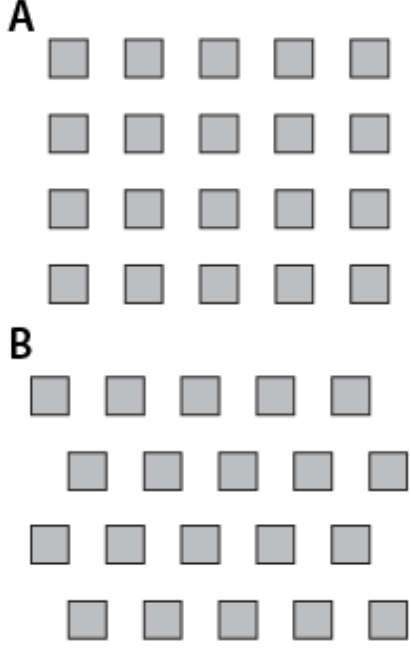
Figure 2. The two grid arrangements, ( A ) normal grid arrangement and ( B ) grid arrangement with a slight offset, are largely indistinguishable by the Engineered Roughness Index (ERI) From Graham et al . [73], reproduced by permission of The Royal Society of